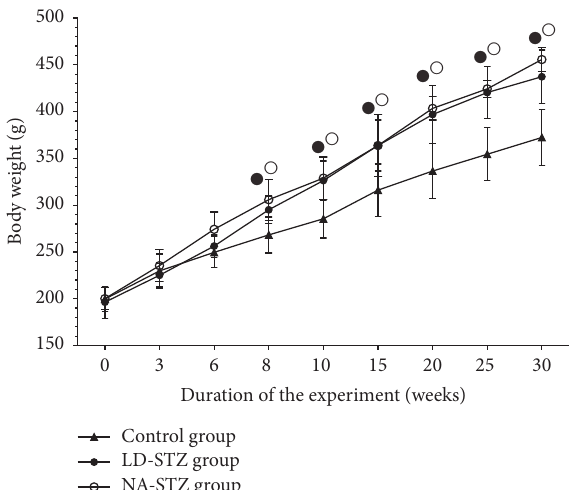
Figure 3: Changes in body weight (g) of rats in the experimental groups throughout the study. Dynamics of body weight starting at week 0 when unilateral nephrectomy was performed. LD-STZ and NA-STZ groups were fed with the diet containing beef tallow from week 3 till week 8 of the study. Mean values and standard deviations are shown. I – 𝑃 < 0.05 in NA-STZ group versus control nondiabetic group; e - 𝑃 < 0.05 in LD-STZ group versus control nondiabetic group. Nonsignificant difference between NA-STZ and LD-STZ groups is not